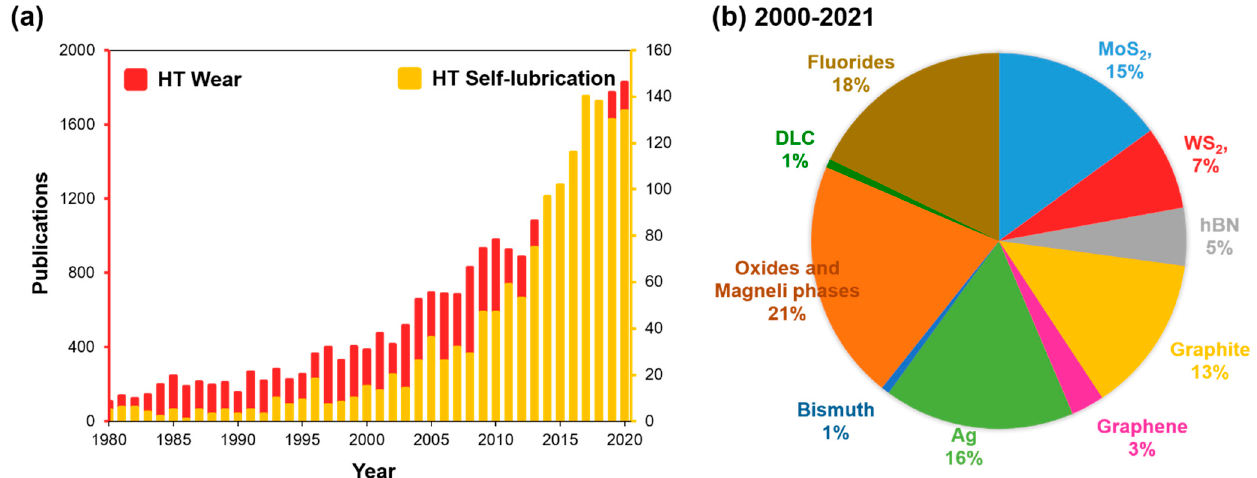
Figure 1. Number of published articles on ( a ) high-temperature wear and self-lubrication (1980–2020); and ( b ) high-temperature self-lubrication based on respective solid lubricants (percentage, 2000–2021), as recovered from Scopus database.